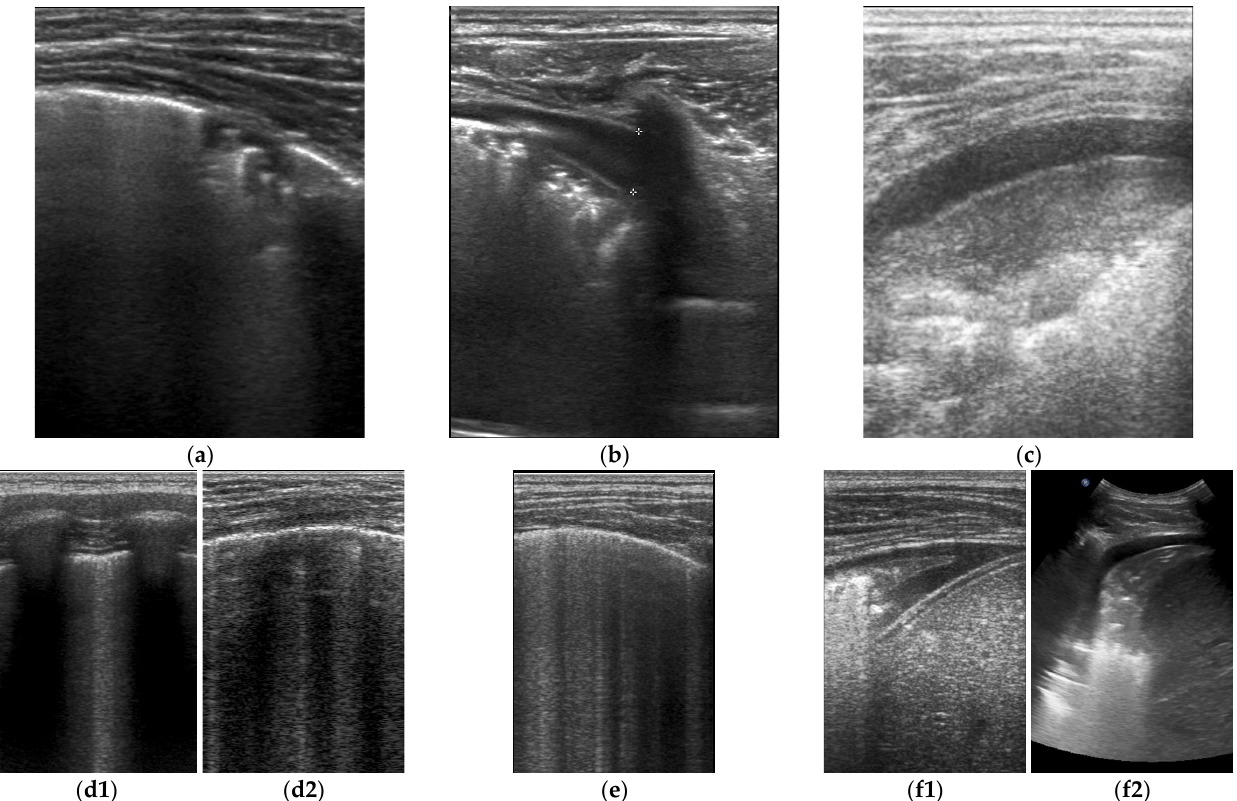
Figure 1. LUS images ( a )—consolidation; ( b , c )—consolidation and fluid in pleural cavity; ( d1 )— interstitial syndrome—a longitudinal projection; ( d2 )—interstitial syndrome—a transversal pro- jection; ( e )—interstitial-alveolar syndromes; ( f1 )—atelectasis with consolidation and pleural effu- sion/linear probe/; ( f2 )—atelectasis with consolidation and pleural e ff usion/curvilinear probe/.